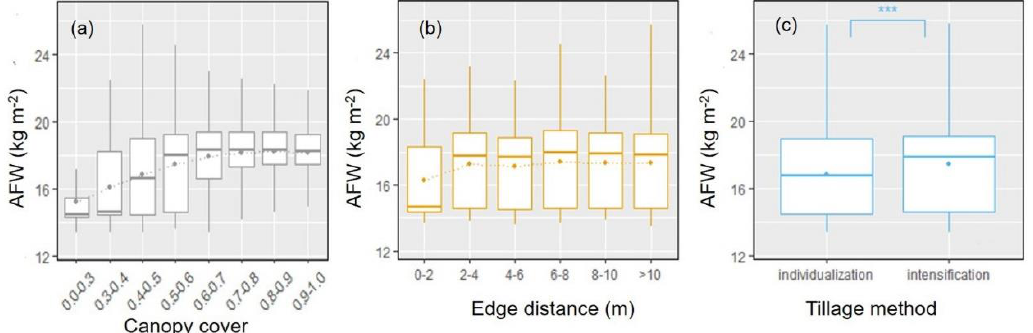
Figure 5. The influence of canopy cover, the distance to the road, and tillage method on the performance of sugarcane aboveground fresh weight (AFW). ( a ) Gray dots represent the average AFW value. ( b ) Orange dots represent the average value of AFW. ( c ) Blue dots represent the average AFW value. Stars indicate a significant difference between individualization and intensification ( p < 0.001).